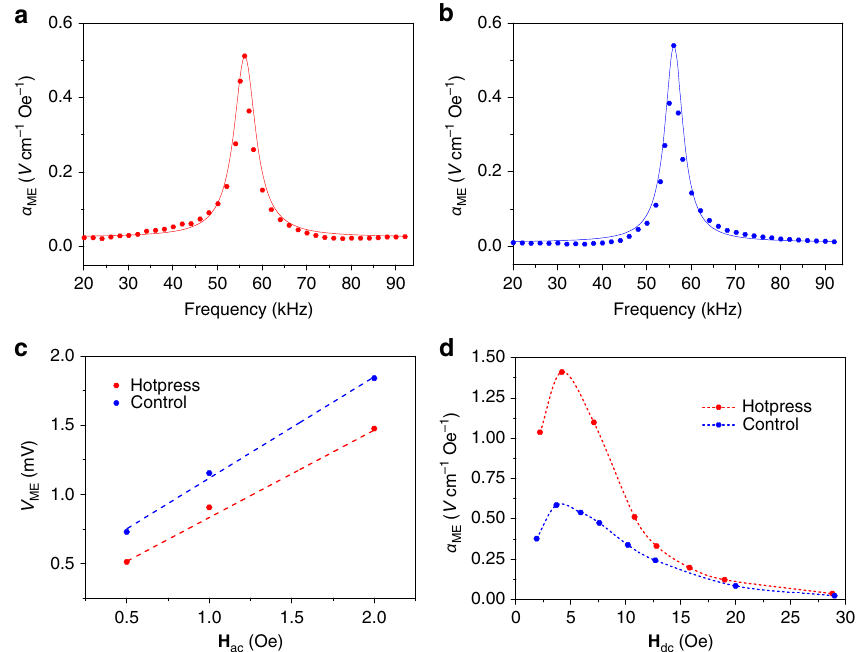
Fig. 2 ME effect of cellulose-Metglas laminates. a , b ME voltage coef fi cient as a function of H ac frequency when a H dc = 10.8 Oe for hot-press sample and b H dc = 5.9 Oe for the control sample. The experimental data points are fi tted to a Lorentzian resonance model (the solid line ) and the resonance peaks found at 56.1 kHz. c The resonant ME output voltage as a function of applied H dc strength. The ME laminates were induced by H dc = 10.8 Oe for hot-press sample and H dc = 5.9 Oe for the control sample at which a Lorentzian resonance pro fi le has been observed. d Resonance enhanced α ME as a function of H dc for hot press ( red dotted line ) and control ( blue dotted line ). All data are obtained under H ac = 0.5